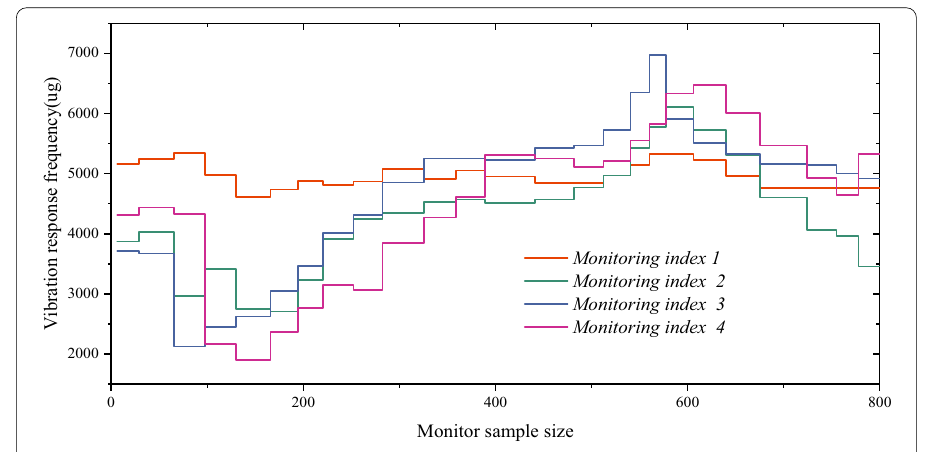
Fig. 5 Response speed performance results of mechanical vibration monitoring technology